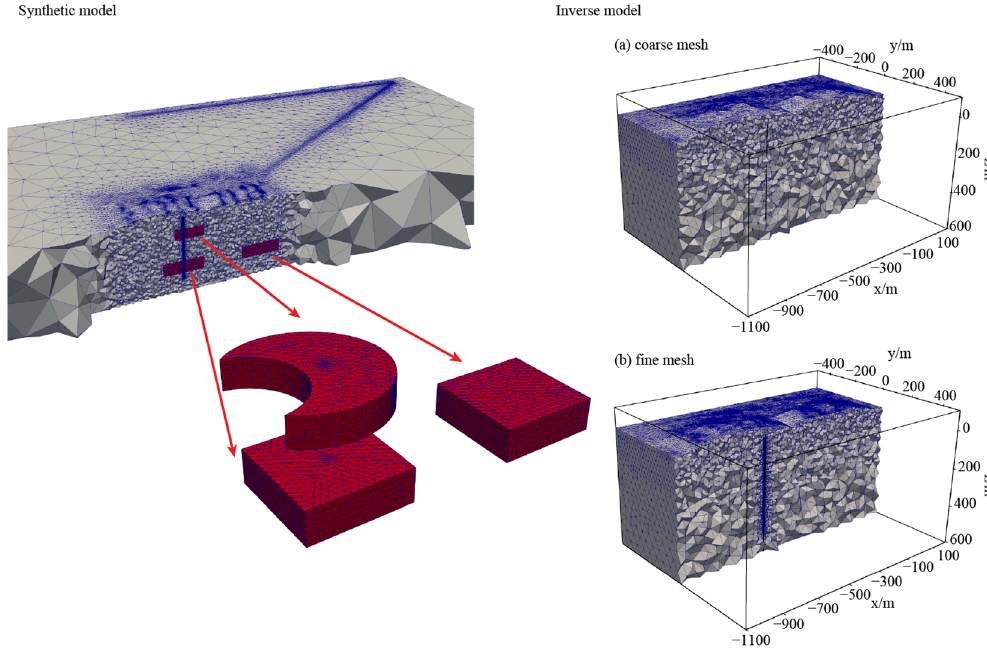
Figure 7. Three 3D abnormal bodies embedded in a topographic half-space.